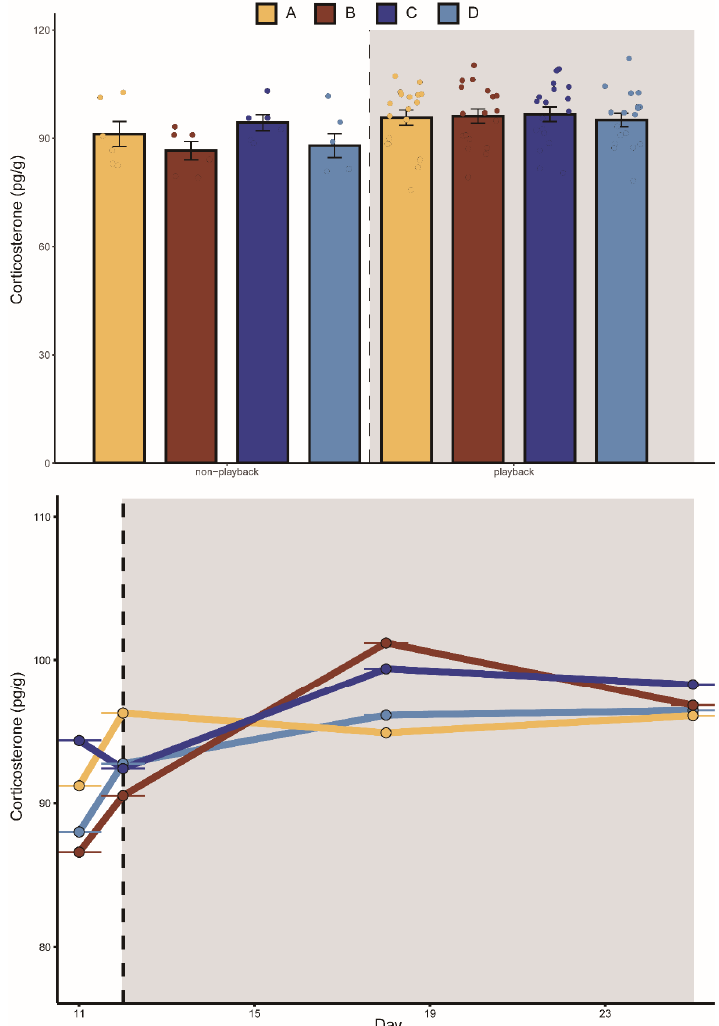
Figure 4. Change in corticosterone concentration of bats in different groups. The playback period is represented by the dark grey box. A represents the noisy-calls playback group, B represents the tonal-calls playback group, C represents the white-noise playback group, and D represents the control group. The bar chart shows the results of the Kruskal–Wallis test, and the data are presented as mean ± standard error of the mean.